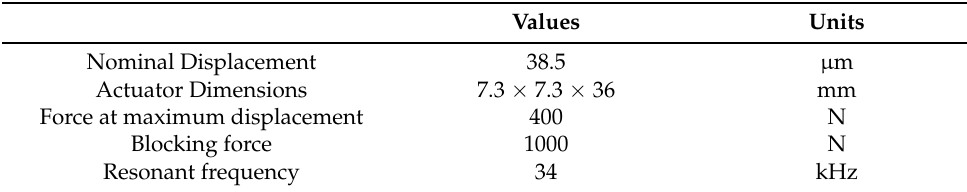
Table 1. Piezoelectric actuator (PEA) specifications.